Question: Provide a one-line summary of what is displayed.
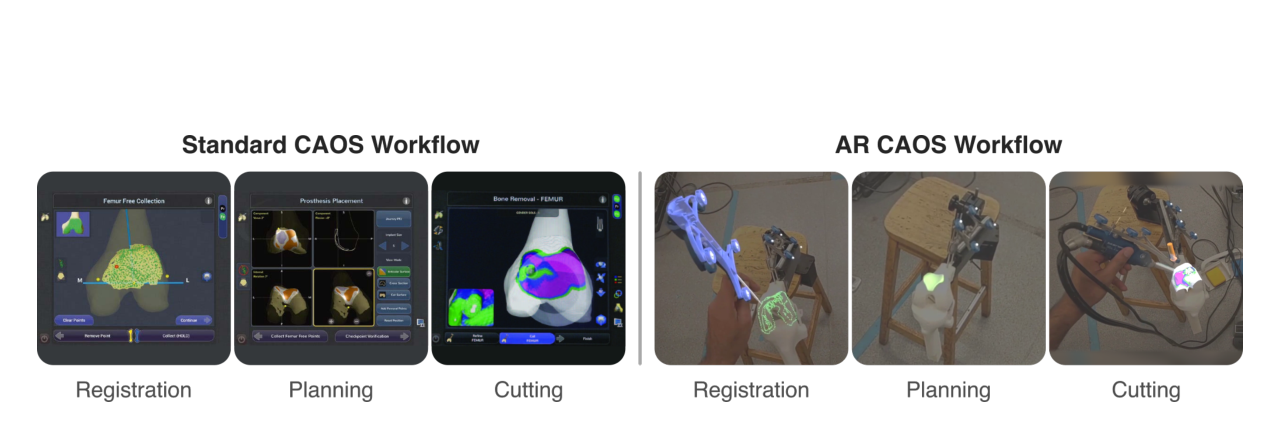
Answer: Comparison of workflows designed for computer and robot-assisted patellofemoral arthroplasty (PFA). Left: screenshots of the standard, monitor- based workflow run by the NAVIO® robot – a commercial CAOS system. Right: Screenshots of our novel AR-centric workflow which reproduces the NAVIO® robot’s entire surgical workflow for PFA in a 3D AR environment through an HMD [8] – an application of the AR-registration method described in this paper.